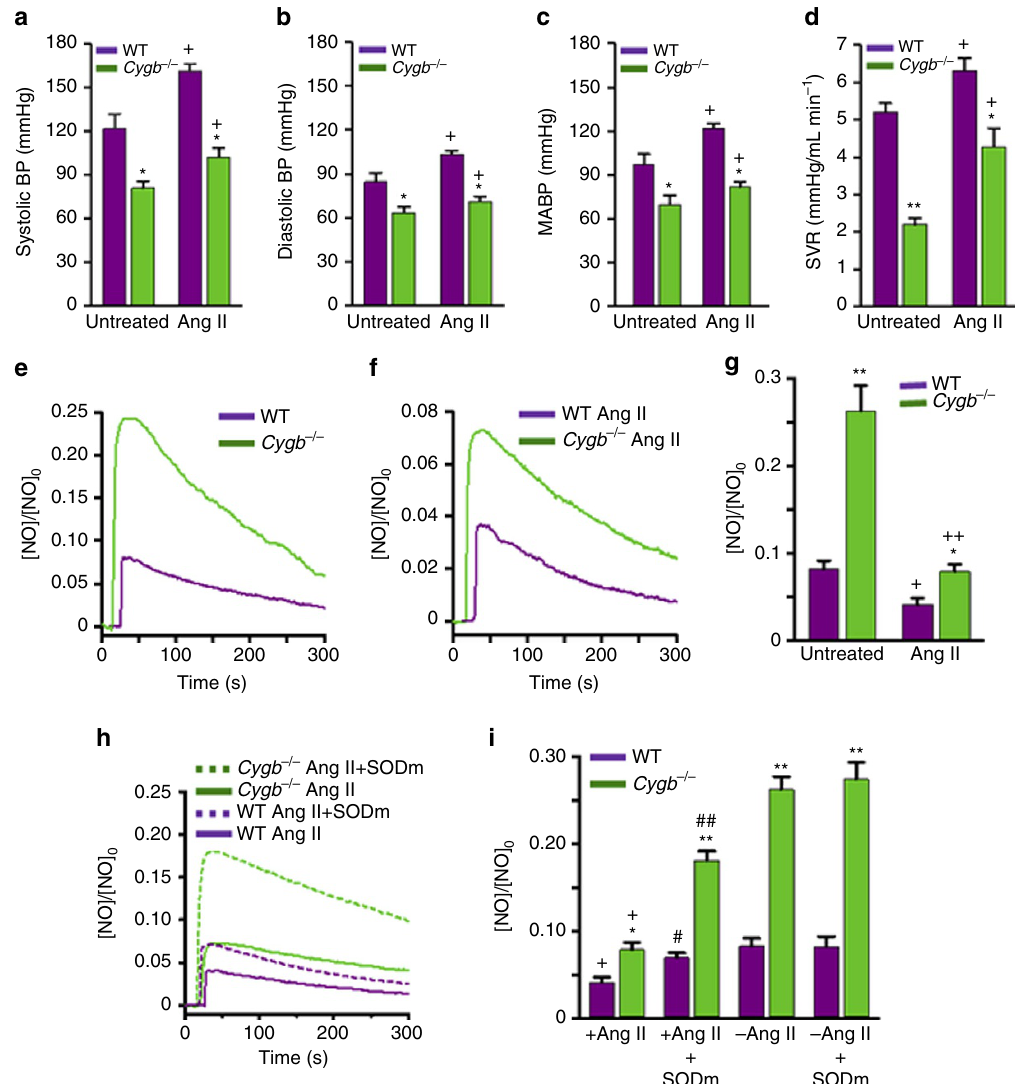
Figure 7 | Effect of Ang II treatment on blood pressure, vascular resistance and NO metabolism. Systolic ( a ), diastolic ( b ), mean arterial blood pressure (MABP) ( c ) and systemic vascular resistance (SVR) ( d ) of mice with and without Ang II treatment. Measurements were performed after 4 weeks of Ang II administration by osmotic pump, n ¼ 5–7 per group. The flux of NO diffusion across the wall of mesenteric arteries from these control or Ang II-treated mice was measured by cylindrical carbon electrodes ( e , f ). NO was injected into the solution to achieve an initial concentration of 0.5 m M. The average NO diffusion flux through the wall of control or Ang II-treated mouse mesenteric resistance arteries, n ¼ 5 per group, is shown ( g ). Effect of SOD mimetic (SODm) on the flux of NO across the mesenteric artery wall of Ang II-treated WTand Cygb (cid:3) / (cid:3) mice ( h ). Comparison of the flux of NO diffusion across the wall of mesenteric artery segments from untreated or Ang II-treated mice in the presence/absence of SOD mimetic ( i ), n ¼ 5 per group. * P o 0.05, ** P o 0.01 WT versus Cygb (cid:3) / (cid:3) . þ P o 0.05, þ þ P o 0.01 WT or Cygb (cid:3) / (cid:3) untreated versus Ang II treated. # P o 0.05, ## P o 0.01 WT or Cygb (cid:3) / (cid:3) Ang II treated versus Ang II treated þ SODm. Error bars: mean ± s.e.m.; P values determined using a two-tailed t